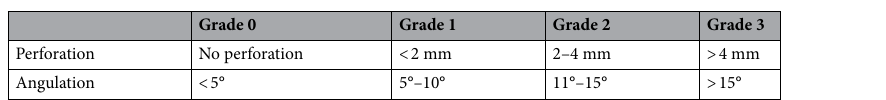
Table 1. Definitions and results of mal-positioned iliosacral screw and trans-iliac trans-sacral screws as per Smith grading